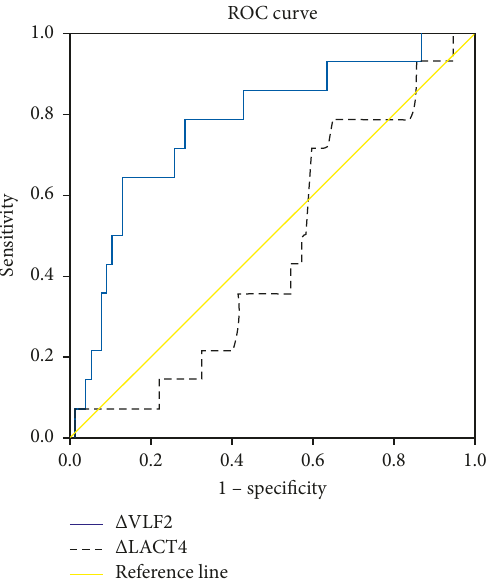
Figure 2: Receiver-operating characteristic curve identifying changes in VLF at 2 hours (AUC 0.772, 95% CI 0.633, 0.911, p 0 . 001) from baseline as a significant indicator of ICU ad- (cid:31) mission. Change in serum lactate at 4 hours (AUC 0.459, 95% CI 0.31, 0.60, p 0 . 62) is shown as a (cid:31)